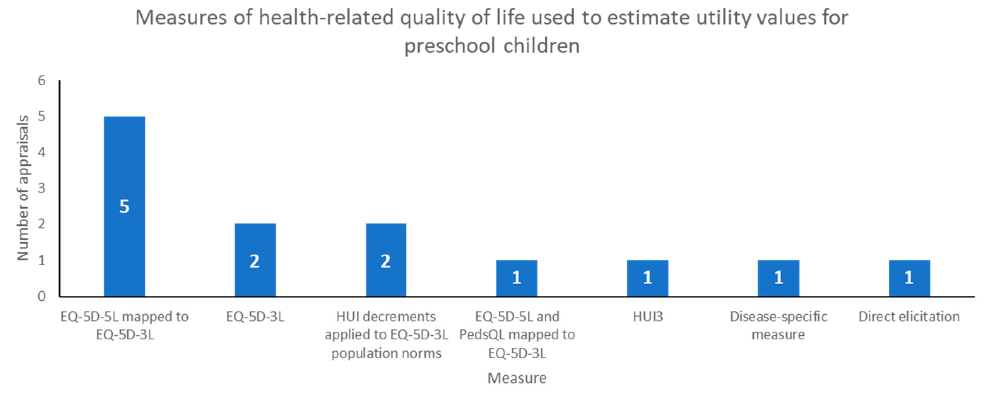
Figure 2. Measures used in NICE appraisals to estimate utility values for preschool children.